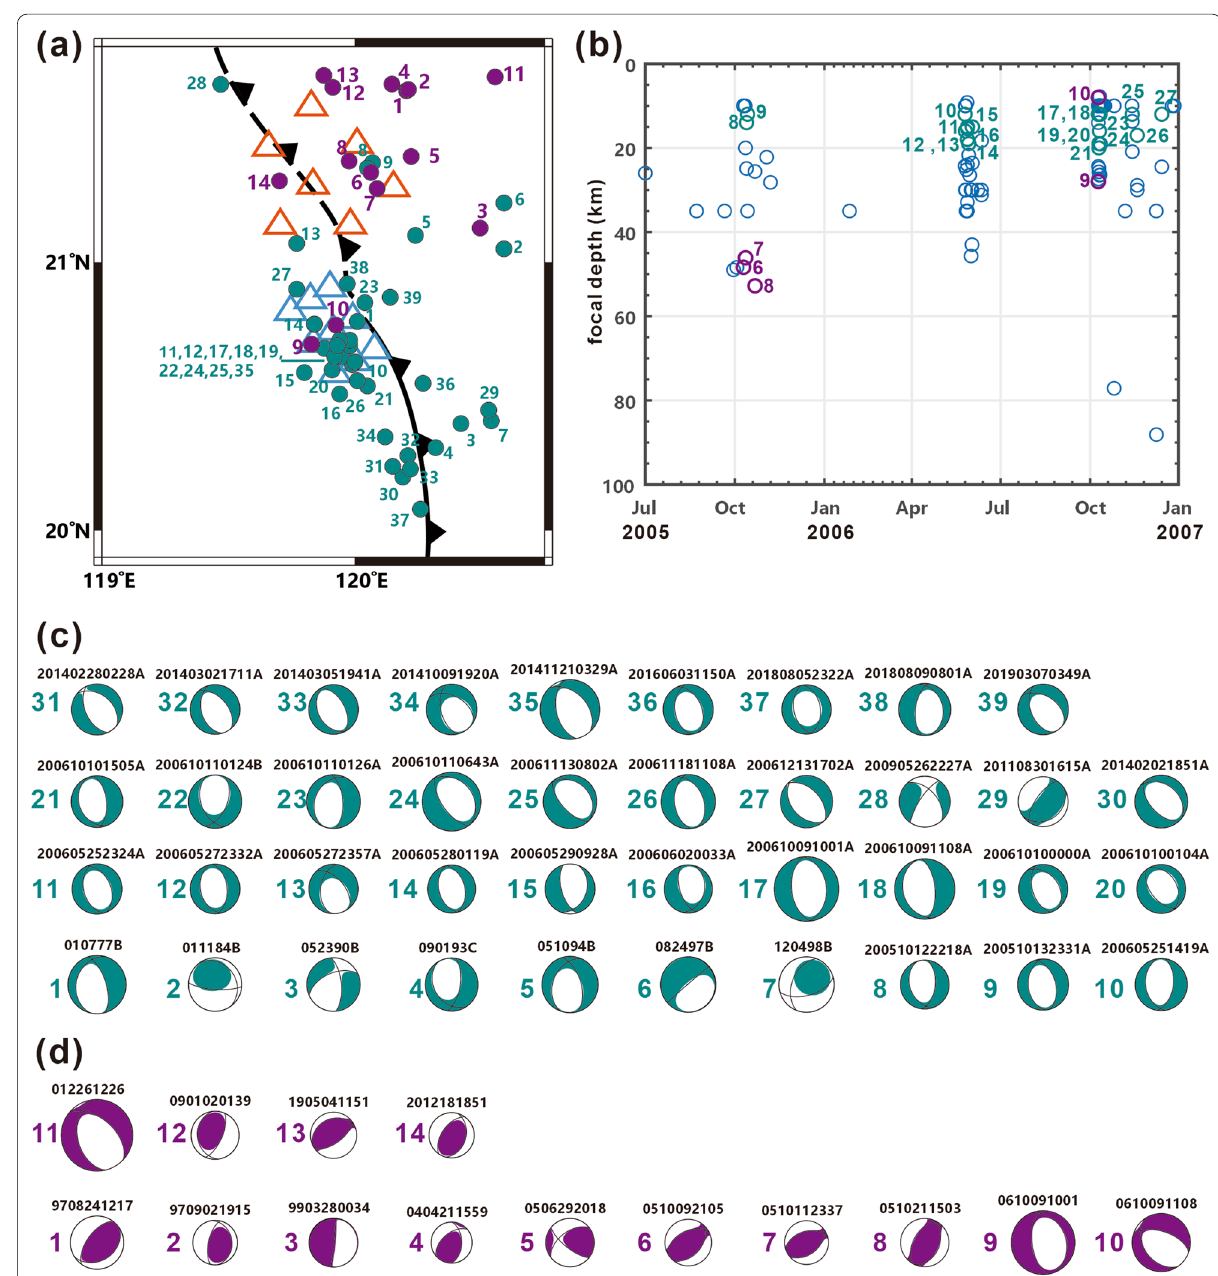
Fig. 2 Hypocenters and focal mechanism of the earthquakes in the global and regional earthquake catalogs for the study area. The GCMT events are indicated by green dots in a and by the color green in the compressional quadrants in c ; the AutoBATS events are indicated by the color purple in a and d . b Presents the temporal evolution of the seismicity for the period from July 2005 to December 2006 in the study area. The circles outlined in blue indicate the United States Geological Survey